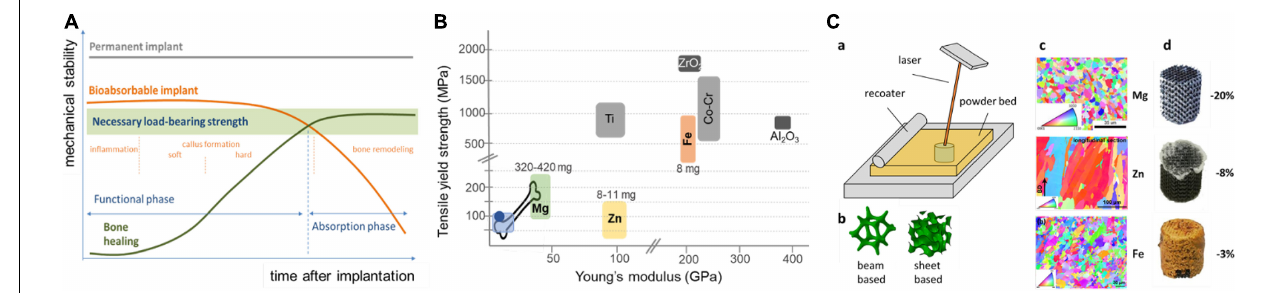
FIGURE 1 | Schematic representation of requirements, material properties, and corrosion characteristics of absorbable metals for bone repair. (A) Relationship between corrosion speed-dependent mechanical support (orange line) of an absorbable implant (Hermawan, 2018) and projected mechanical support by bone regeneration (green line). Stages of bone healing are indicated in orange. Dependent on the defect site and size, mechanical implant integrity should remain high enough for about 3–6 months, to ensure initial mechanical support prior to implant failure by progressive corrosion. (B) Comparison of mechanical properties of selected biomaterials to those of bone (lower left values = trabecular, upper right values = cortical), polymers [e.g., poly(lactic acid), poly(glycolic acid), or polyhydroxybutyrate in light blue; polyetheretherketone in dark blue], Mg/alloys (green), titanium (Ti)/alloys (gray), Zn/alloys (yellow), iron/steel (brownish), cobalt-chromium (Co-Cr)/alloys (light gray), and ceramics (ZrO 2 and Al 2 O 3 , dark gray). Age- and gender-dependent Dietary Intake Recommendations (DRI) for Mg, Zn and Fe (in mg) are values for older adults (females-males) (Marian and Sacks, 2009). Note that DRI of Mg is 42 times higher than that of Fe and Zn, respectively. (C) Schematic of an SLM process (a) with different topological designs of absorbable metals (b), and Electron Back-Scattered Diffraction (EBSD) images of these SLM metals (c), next to the macroscopic appearance of identically designed scaffolds with their respective weight loss (%) after 28 days of standardized quasi-physiological in vitro absorption (d). Note the white and brownish corrosion products on Zn and Fe scaffolds, respectively.